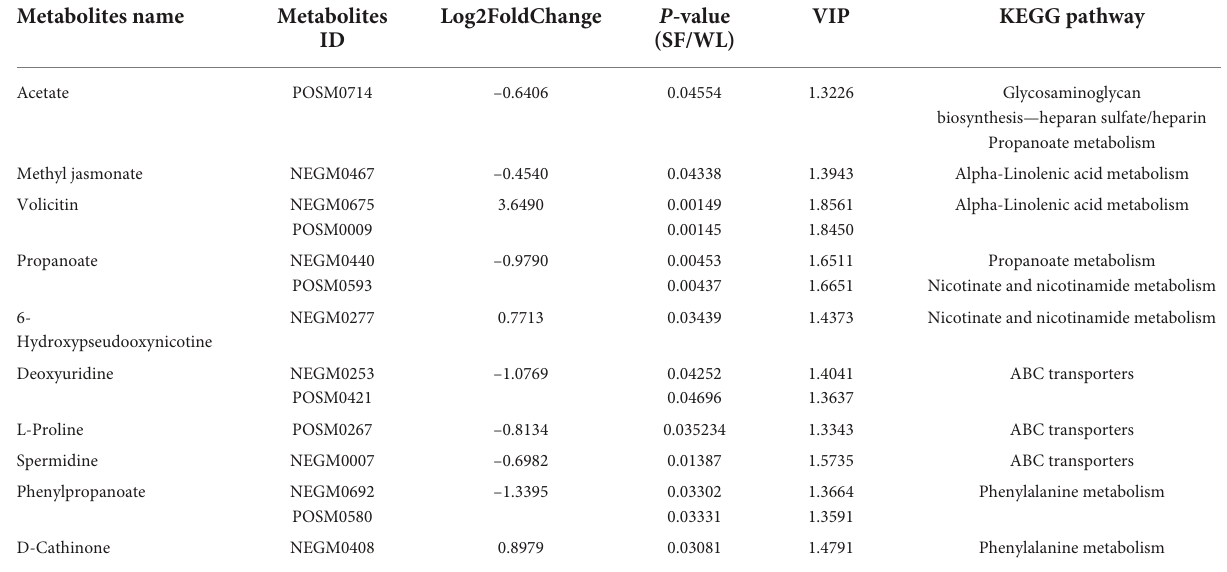
TABLE 1 Differential metabolites that mapped to KEGG